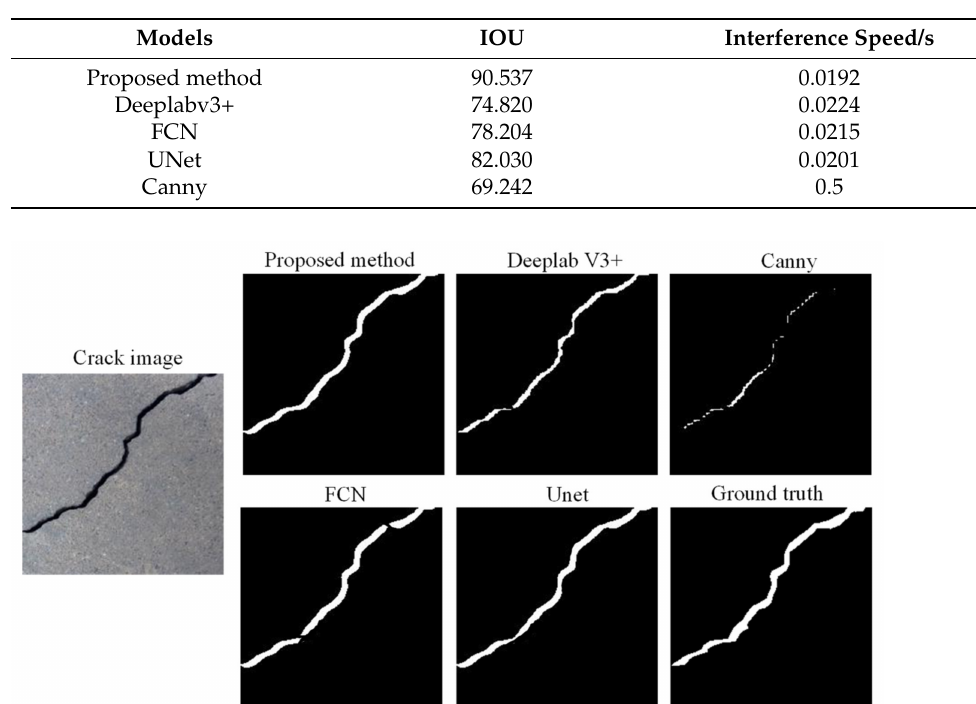
Table 4. Comparative evaluation of crack detection results of different segmentation methods.